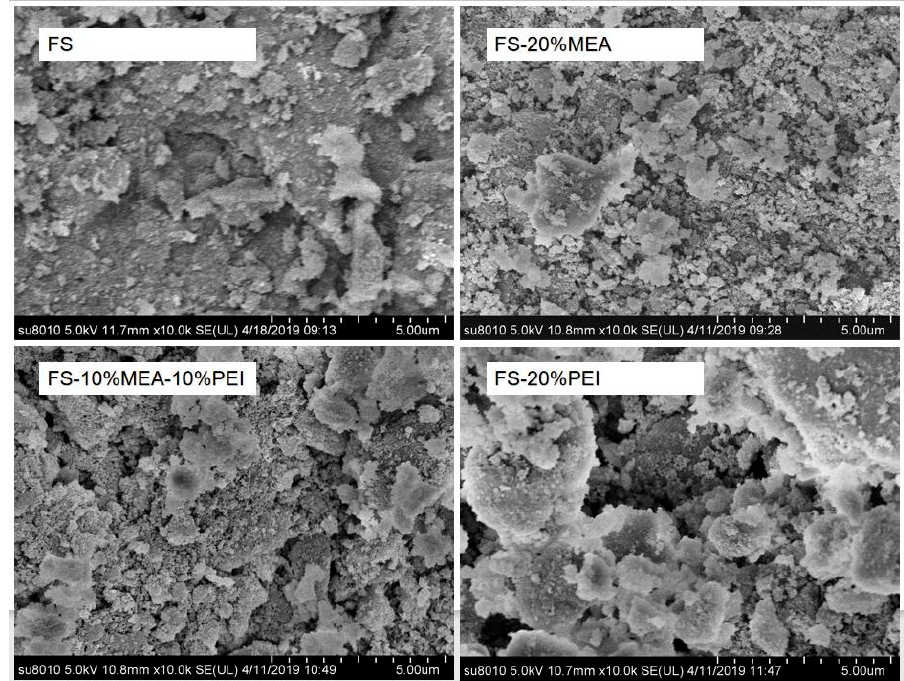
Figure 5. SEM images of different samples.